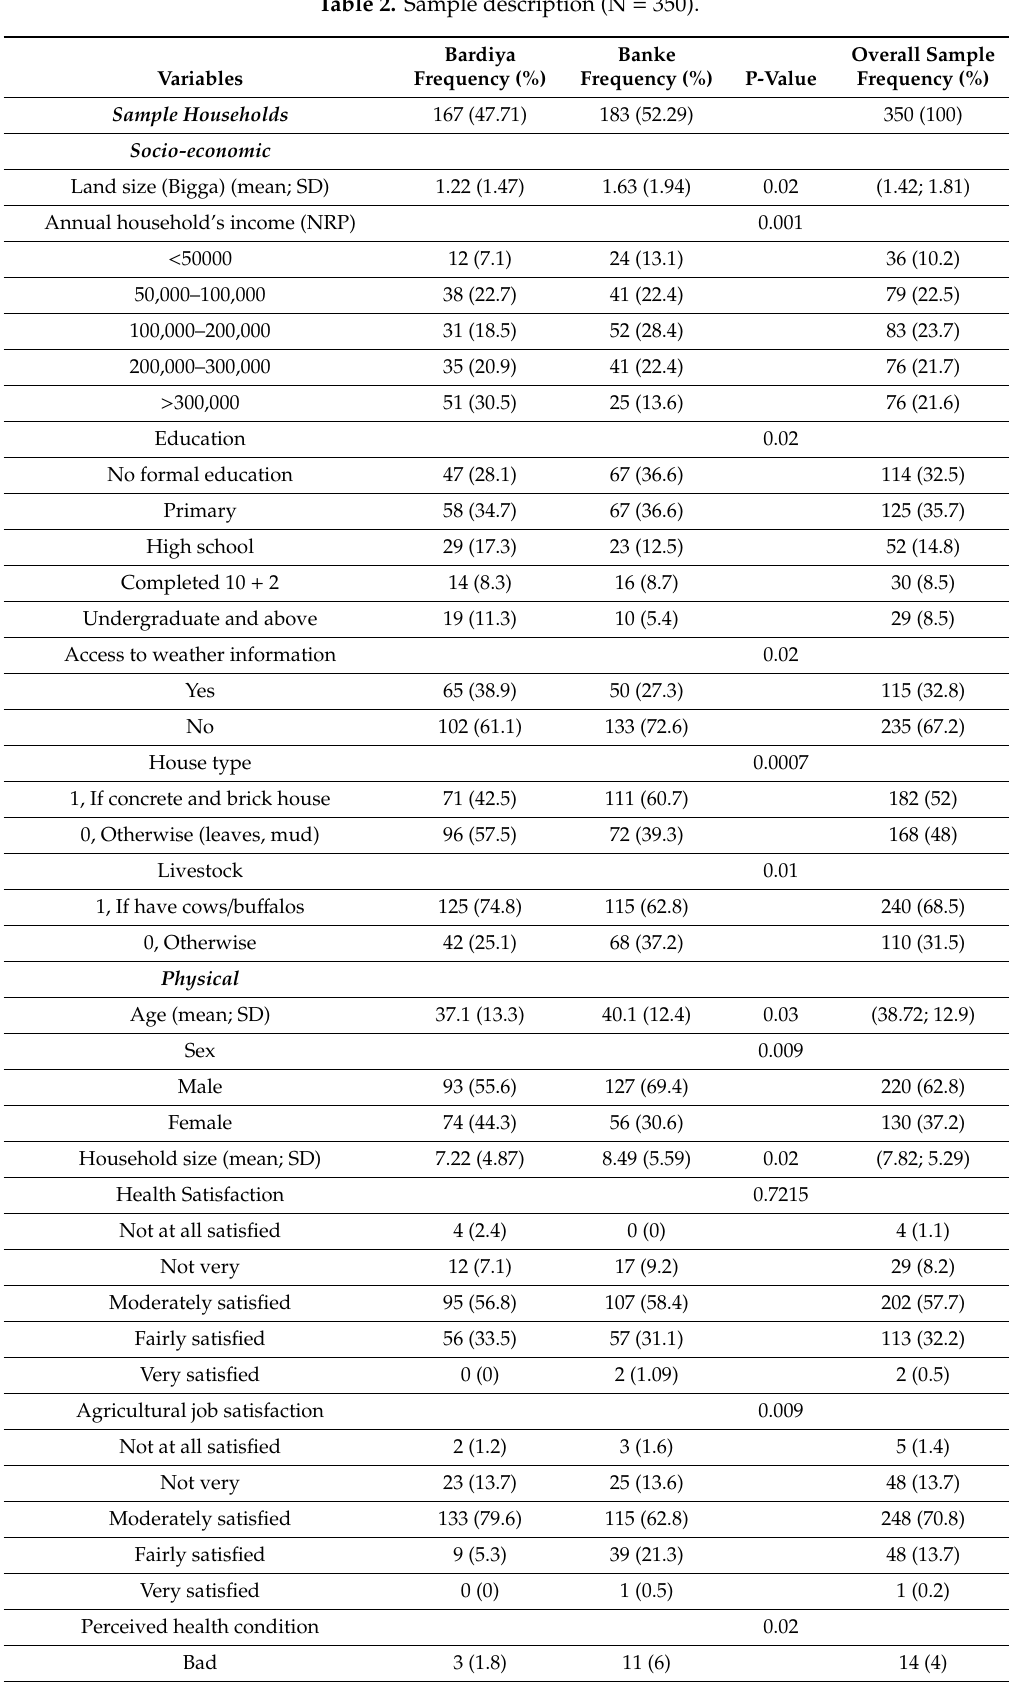
Table 2. Sample description (N =